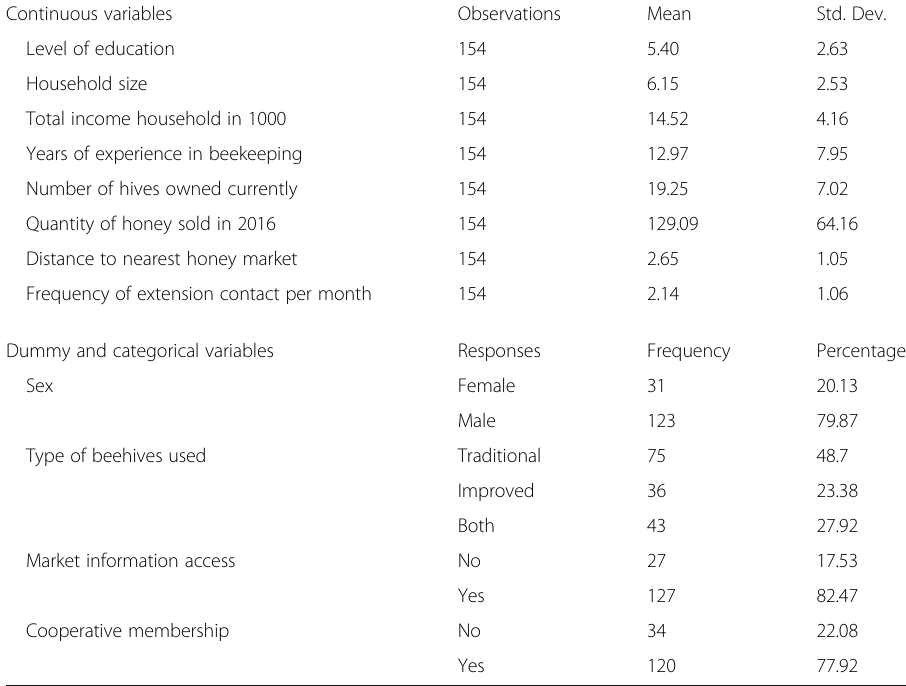
Table 2 Summary statistics of variables Continuous